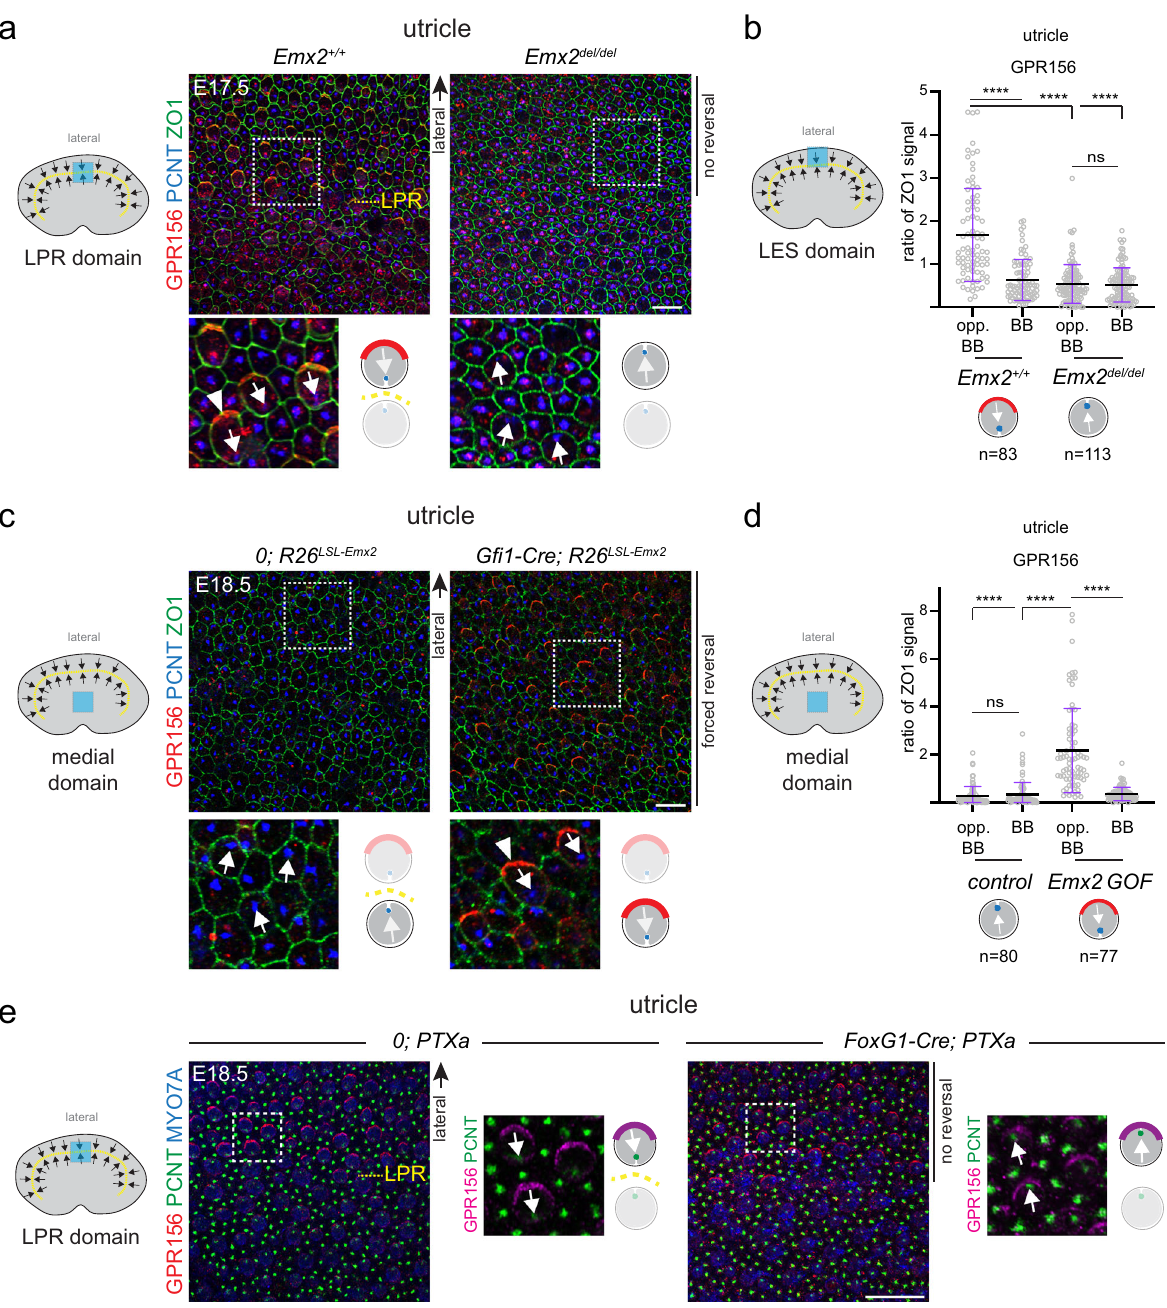
Fig. 3 EMX2 > GPR156 > G α i epistasis in the mouse macular organs. a LPR domain in E17.5 utricles. Polarization of GPR156 in lateral HCs (arrowhead) is lost when EMX2 is missing and these HCs fail to reverse. b GPR156 enrichment in the lateral utricle (LES) domain. c Medial domain in E18.5 utricles. Ectopic expression of Emx2 reverses HC orientation and induces polarization of GPR156 (arrowhead) in medial HCs. d GPR156 enrichment in the utricle medial domain. e LPR domain in E18.5 utricles. Polarization of GPR156 in lateral HCs expressing PTXa is intact although these HCs fail to reverse. Utricles are labeled with GPR156, PCNT, and ZO1 ( a , c ) or MYO7A ( e ). In a , c , e boxed areas are magni fi ed in the lower panels, and HC orientation and GPR156 distribution are summarized in a cartoon form. In b , d GPR156 enrichment is measured at the junction opposite (opp. BB) or near (BB) the basal body in the same HC. GPR156 is expressed as ratio of ZO1 signal (mean ± SD; n, HC numbers in 3 or more animals; Kruskal-Wallis test, **** p < 0.0001, ns p > 0.9999). Arrows indicate HC orientation based on PCNT-labeled basal body. Utricle schemes indicate the domain imaged or analyzed (blue). Yellow dashed lines represent the LPR in controls. See Supplementary Fig. 3 for related saccule and crista results. Scale bars are 10 µ m ( a , c ), 20 µ m ( e